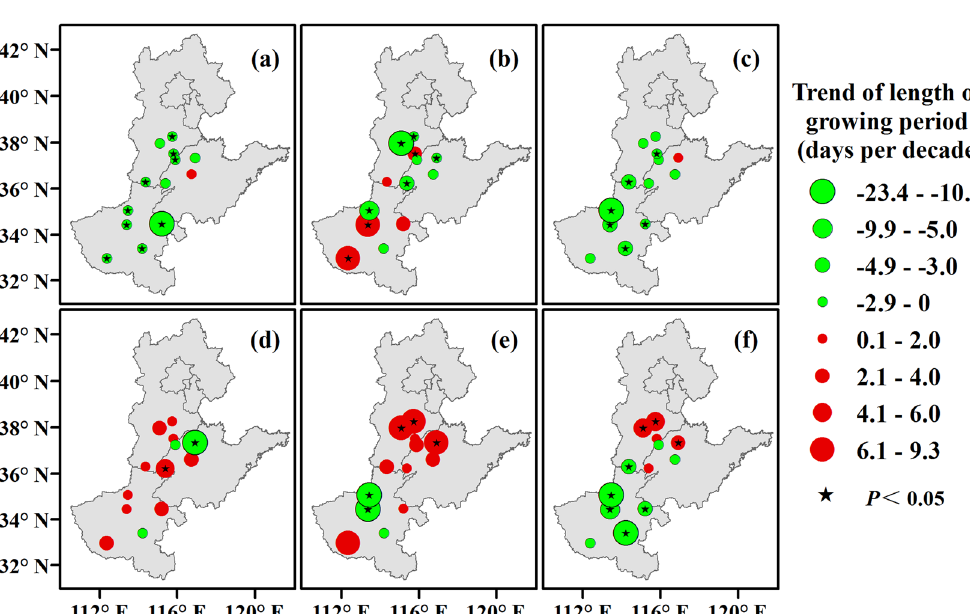
Figure 3. Spatiotemporal changes in the lengths of the sowing-emergence ( a ), emergence-squaring ( b ), squaring-flowering ( c ), flowering-boll opening ( d ), and boll opening-harvest ( e ) periods and the whole growing period ( f ) of cotton across the North China Plain from 1981 to 2012. Green and red circles represent the trends of the lengths of phenological periods. Black pentagrams represent the trends at the stations, with a significance level of 0.05. Maps were generated using ArcGIS 10.1 (ESRI Inc, Redlands, CA, USA,